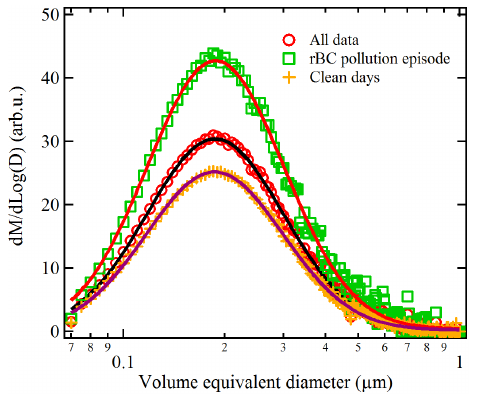
Figure 3. Mass size distribution of rBC in volume-equivalent diam- eter during different sampling periods at Qinghai Lake. The solid lines represent log-normal fit. “M” and “D” in the y -axis label rep- resent rBC mass and void-free diameter (assuming 2gcm − 3 den- sity),